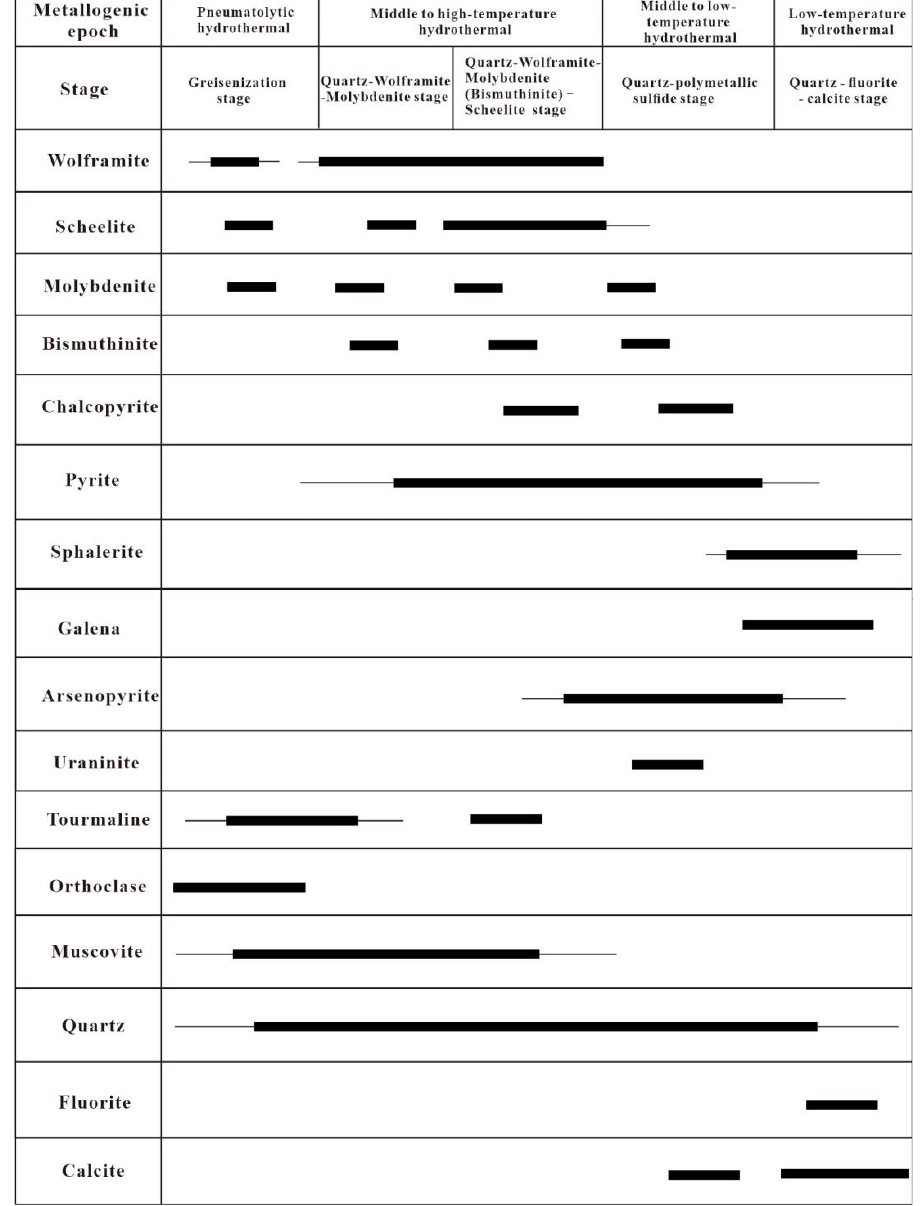
Figure 5. The mineral paragenetic sequence of the Chuankou ore field. (2) The medium- to high-temperature hydrothermal period is the main metallogenic stage and includes the early stages of the quartz vein–wolframite–molybdenite assemblage and the late stage of the quartz–wolframite–molybdenite (bismuthinite)–scheelite assem- blage. During the mineralization process, scheelite and molybdenite crystallized